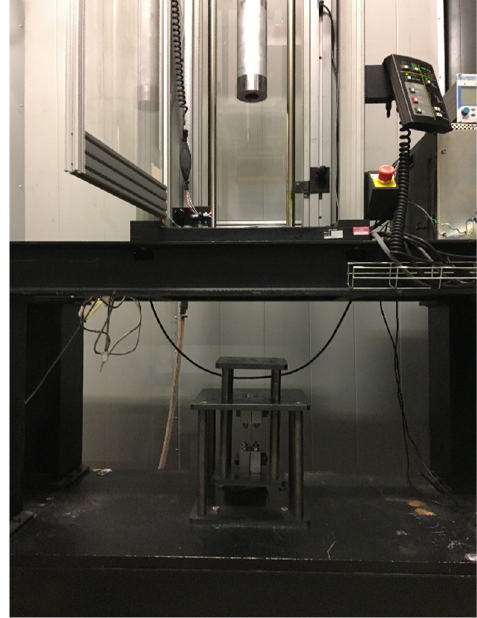
Figure 6. Instron Dynatup 9250 HV drop tower.